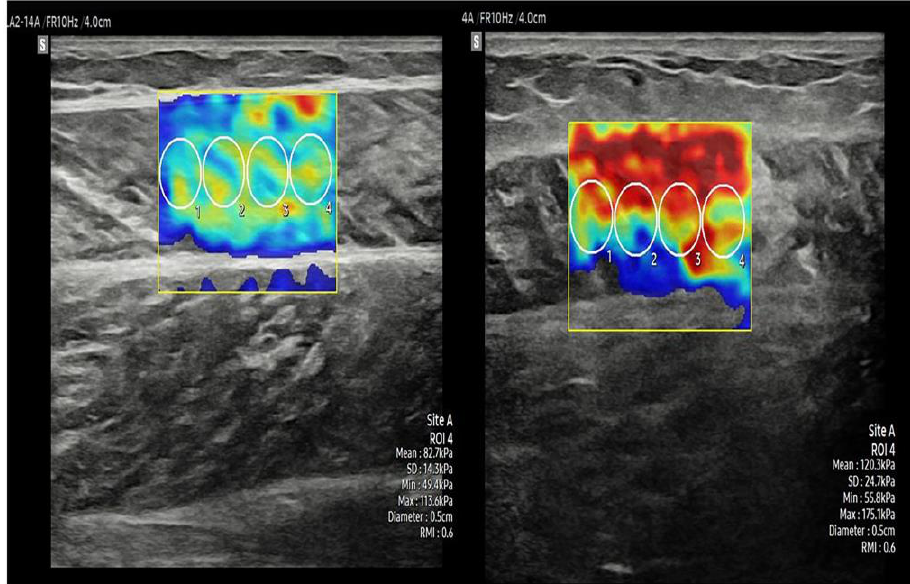
Figure 6. Comparison of contractive stiffness of gastrocnemius medialis between faller ( left ) and non-faller ( right ).